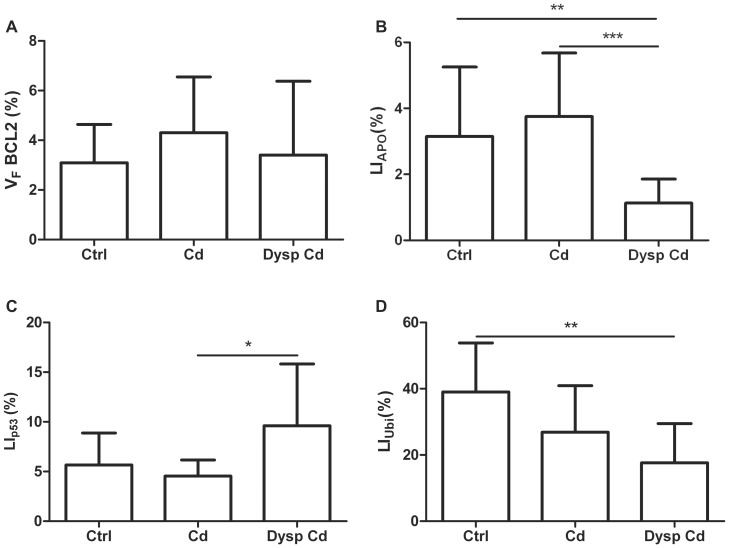
Mean ± SD of VFBcl-2 (A), LIAPO (B), LIp53 (C), and LIUBI (D).Bars showing lines and asterisks on top of the error bars differ significantly (*p<0.05, **p<0.01, ***p<0.001).